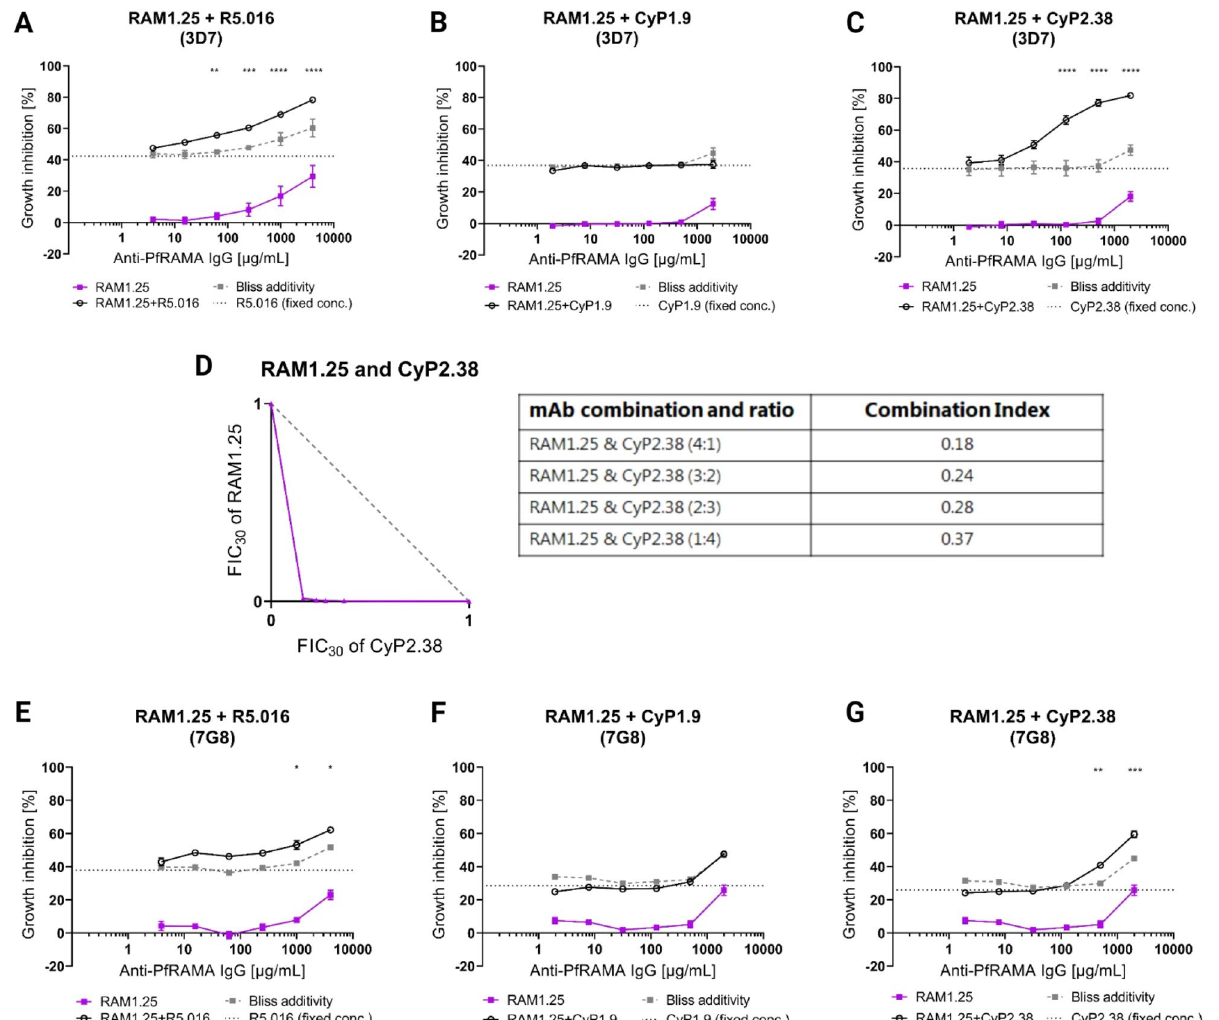
Figure 4. Growth inhibition activity of anti-PfRAMA mAb in combination with anti-PfRh5 or anti- PfCyRPA mAbs. (A) GIA assay using a dilution series of RAM1.25, starting at 4000 µg/mL, mixed with a fixed concentration of anti-PfRh5 mAb (R5.016, 2 µg/mL) against P. falciparum 3D7. (B) GIA assay investigating the effect of combining RAM1.25, starting at 2000 µg/mL, with a fixed concentration of the anti-PfCyRPA mAb (CyP1.9, 10 µg/mL) against 3D7 parasites. (C) Similar GIA assay, exploring the combination of RAM1.25 and a fixed concentration of the anti-PfCyRPA mAb (CyP2.38, 40 µg/mL). (D) Isobologram analysis of the RAM1.25 and CyP2.38 mAb combination using fixed ratio mixtures of (5:0, 4:1, 3:2, 2:3, 1:4 and 0:5) against 3D7 parasites. The dashed grey line indicates the predicted results following the definition of Loewe additivity. The purple line links the observed values of each explored mAb ratio that induces 30% GIA. Points below the line of additivity indicate synergistic interactions between the mAbs, while points above indicate antagonistic interactions. Each point shows the mean of two independent experiments performed in triplicates. The combination index (CI) of the RAM1.25 and CyP2.38 combination, was calculated as the sum of the two FIC 30 values. CI < 1, CI = 1 or CI > 1 respectively indicate synergy, additivity or antagonism. (E) GIA assay against 7G8 parasites using the mAb combination of RAM1.25 and a fixed concentration of R5.016 (5 µg/mL). GIA assay against 7G8 parasites, respectively investigating the effect of combining RAM1.25 with a fixed concentration of CyP1.9 (8 µg/mL) (F) or of combining RAM1.25 with a fixed concentration of CyP2.38 (150 µg/mL) (G) . The formula of Bliss additivity was applied to calculate the predicted additive effect of a specific mAb combination, shown in the grey dotted line. The observed effect of combining two mAbs is shown in the solid black line. Bars show the SEM for six replicates over two experiments. The asterisks indicate where the experimental and the predicted GIA values of the mAb combination significantly show synergy, calculated using a 2-way ANOVA with Bonferroni’s multiple comparison test (*p < 0.05, **p < 0.01, ***p < 0.001, ****p <